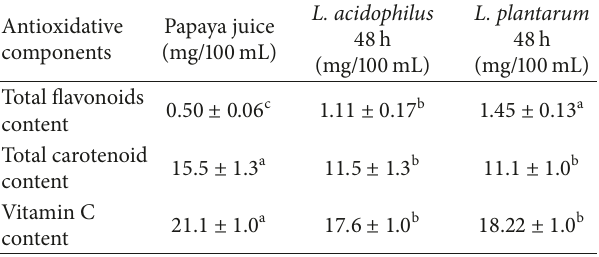
Table 2: Changes in others antioxidative components of the fer- mented papaya